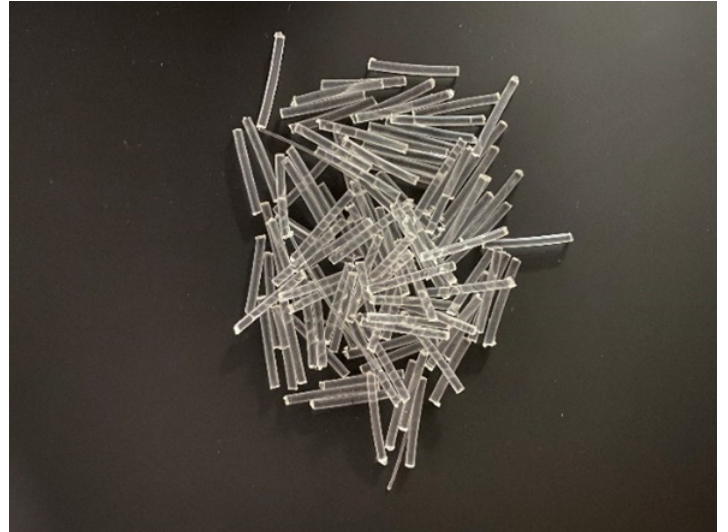
Figure 6. Plastic optical fibers (POF).